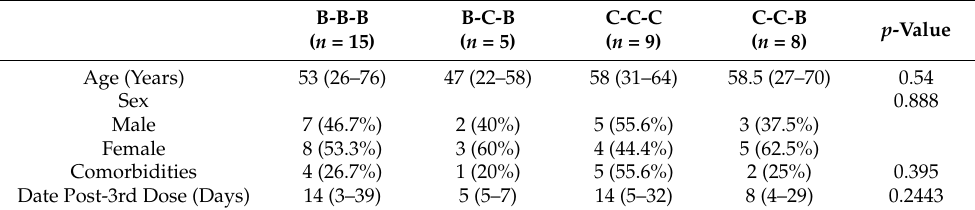
Table 1. Baseline characteristics of subjects.